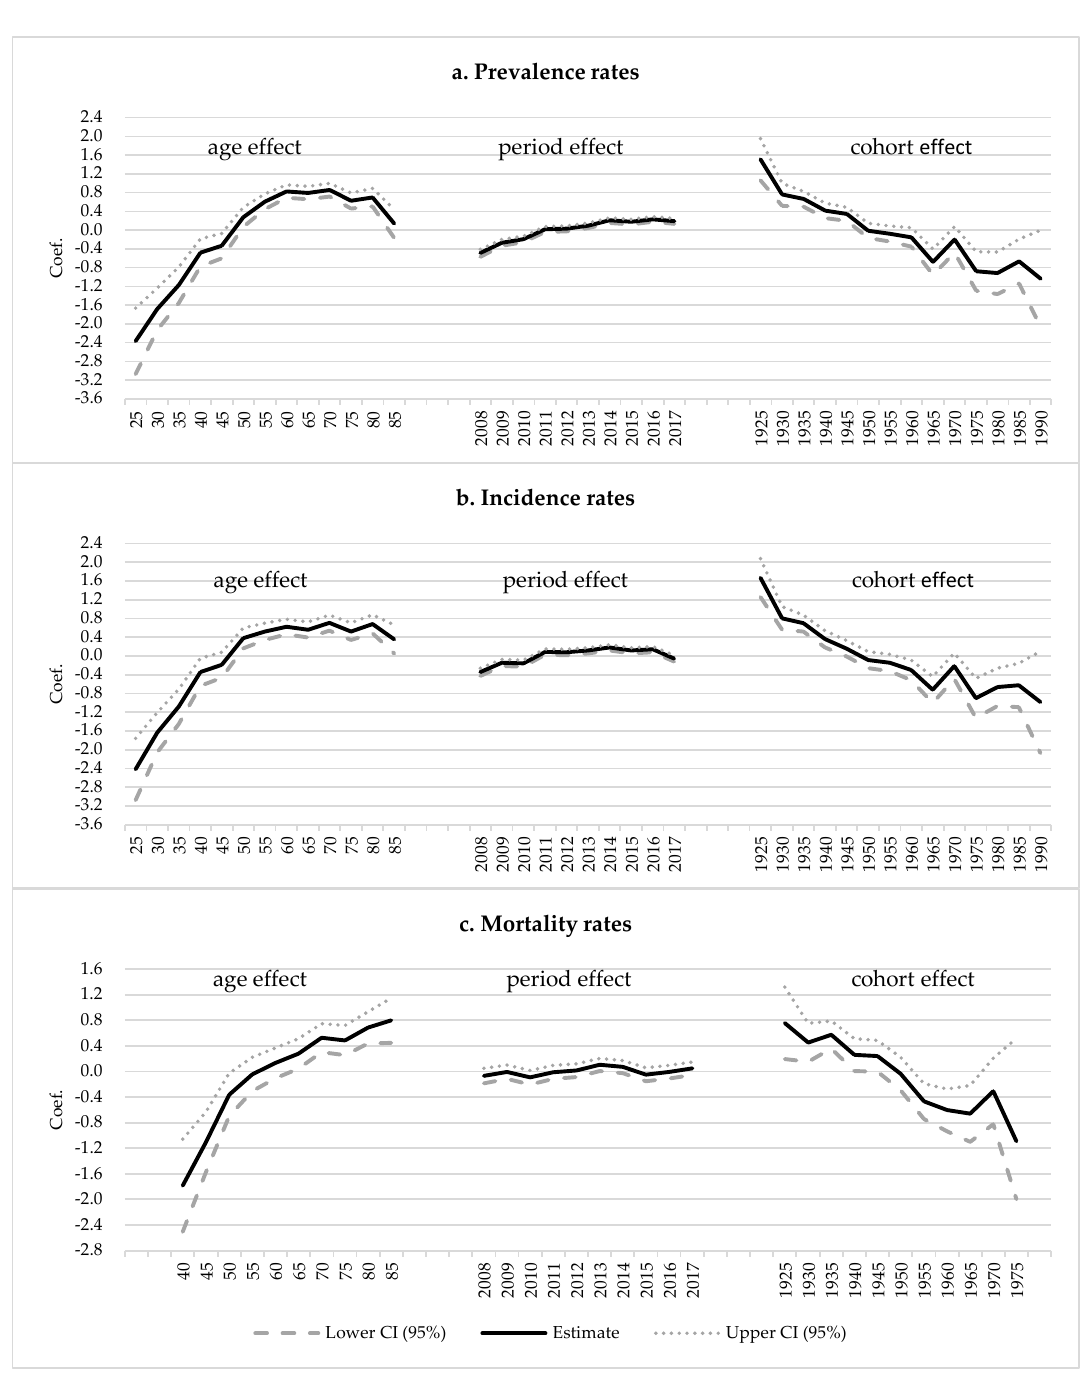
Figure 5. The age, period, and cohort effects on the prevalence, incidence, and mortality of HCC. Note: Some categories of the age and cohort factors are not shown in the figure due to the lack of space. Please refer to Supplementary Table S2 for the detailed statistics.